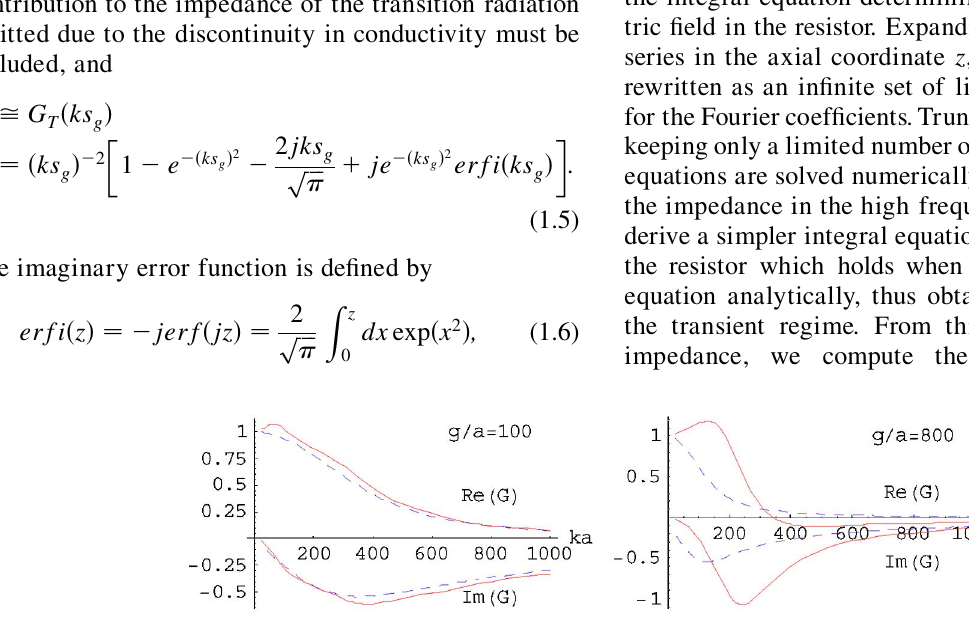
FIG. 3. (Color) The dashed curves representing the transient approximation G curves representing the real and imaginary parts of the function G as determined from a numerical solution of the truncated linear algebraic equations when ka (cid:2) g=a . Results are for a (cid:5) 0 : 01 m and (cid:3) (cid:5) 10 6 (cid:1) ohm m (cid:3) (cid:6) 1